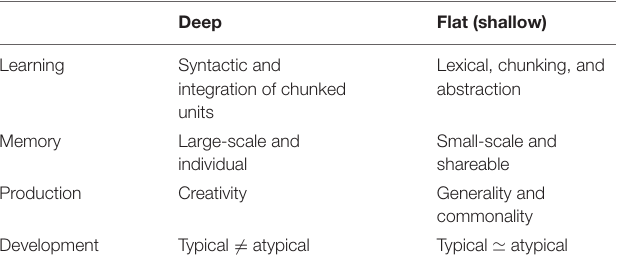
TABLE 1 | Summary of our two proposed levels of statistical learning and statistical